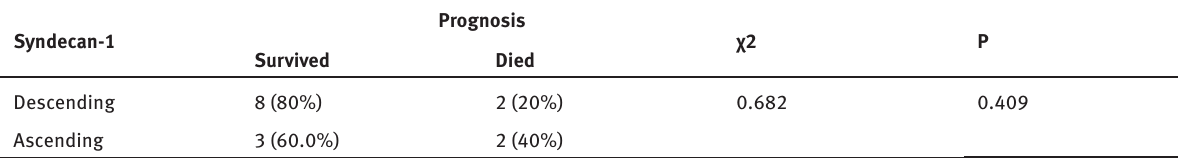
Table 4: Comparison of APACHE II scores, SOFA scores, duration of mechanical ventilation, and length of ICU stay between patients with ascending and descending plasma syndecan-1 concentrations